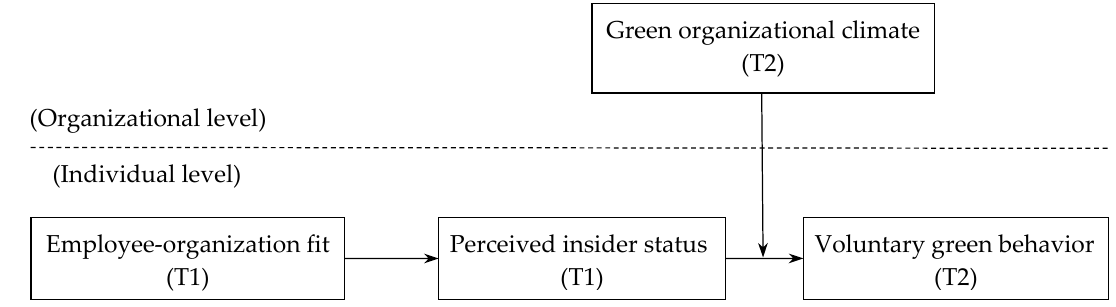
Figure 1. The proposed model of current research. Note: T1 means the data were collected at Time 1, T2 means the data were collected at Time 2.